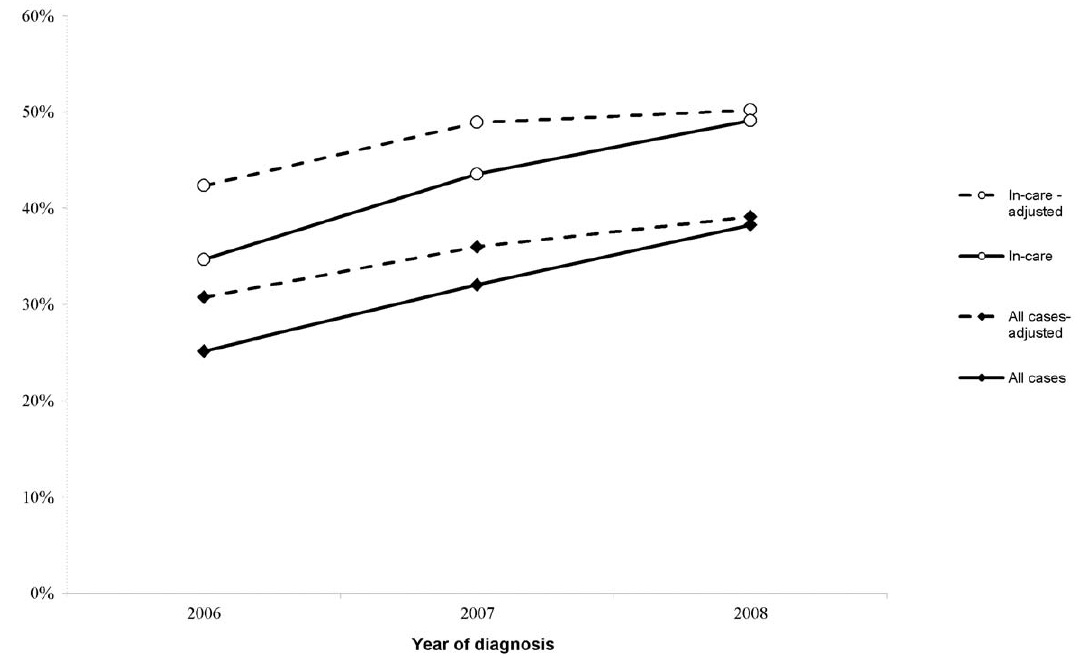
Figure 1. Proportion of cases receiving genotype within 3 months of diagnosis, with adjustment for completeness of reporting.